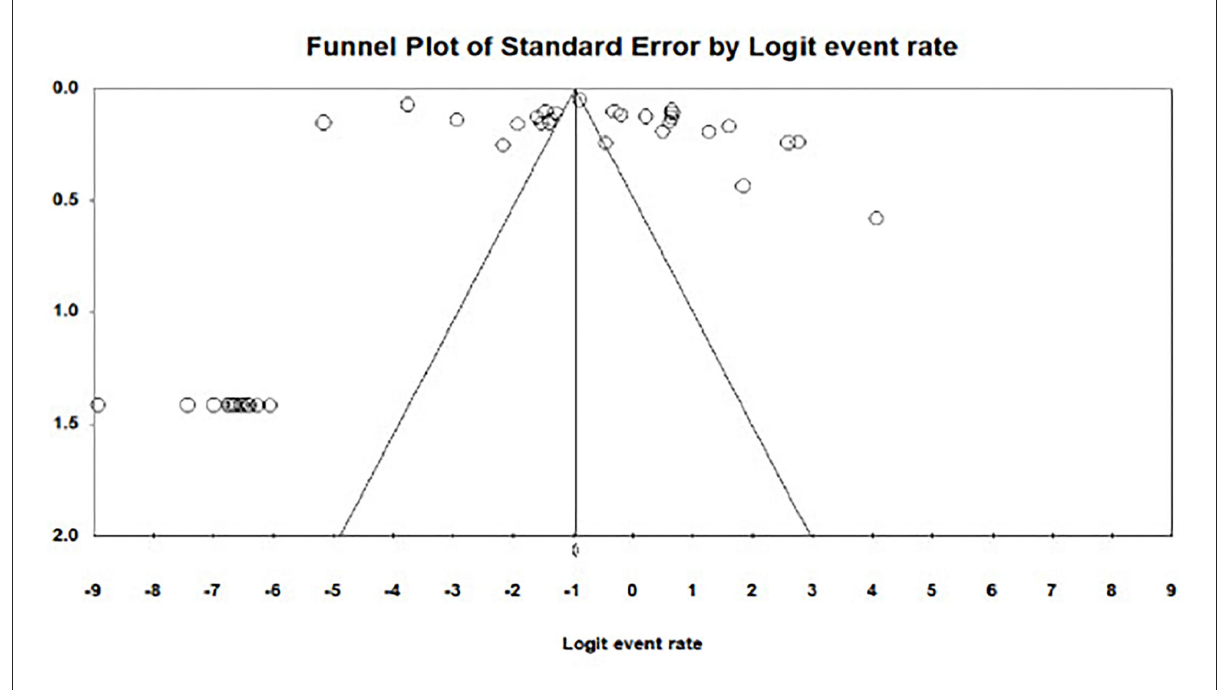
FIGURE5 Publication bias for the adverse maternal outcome.